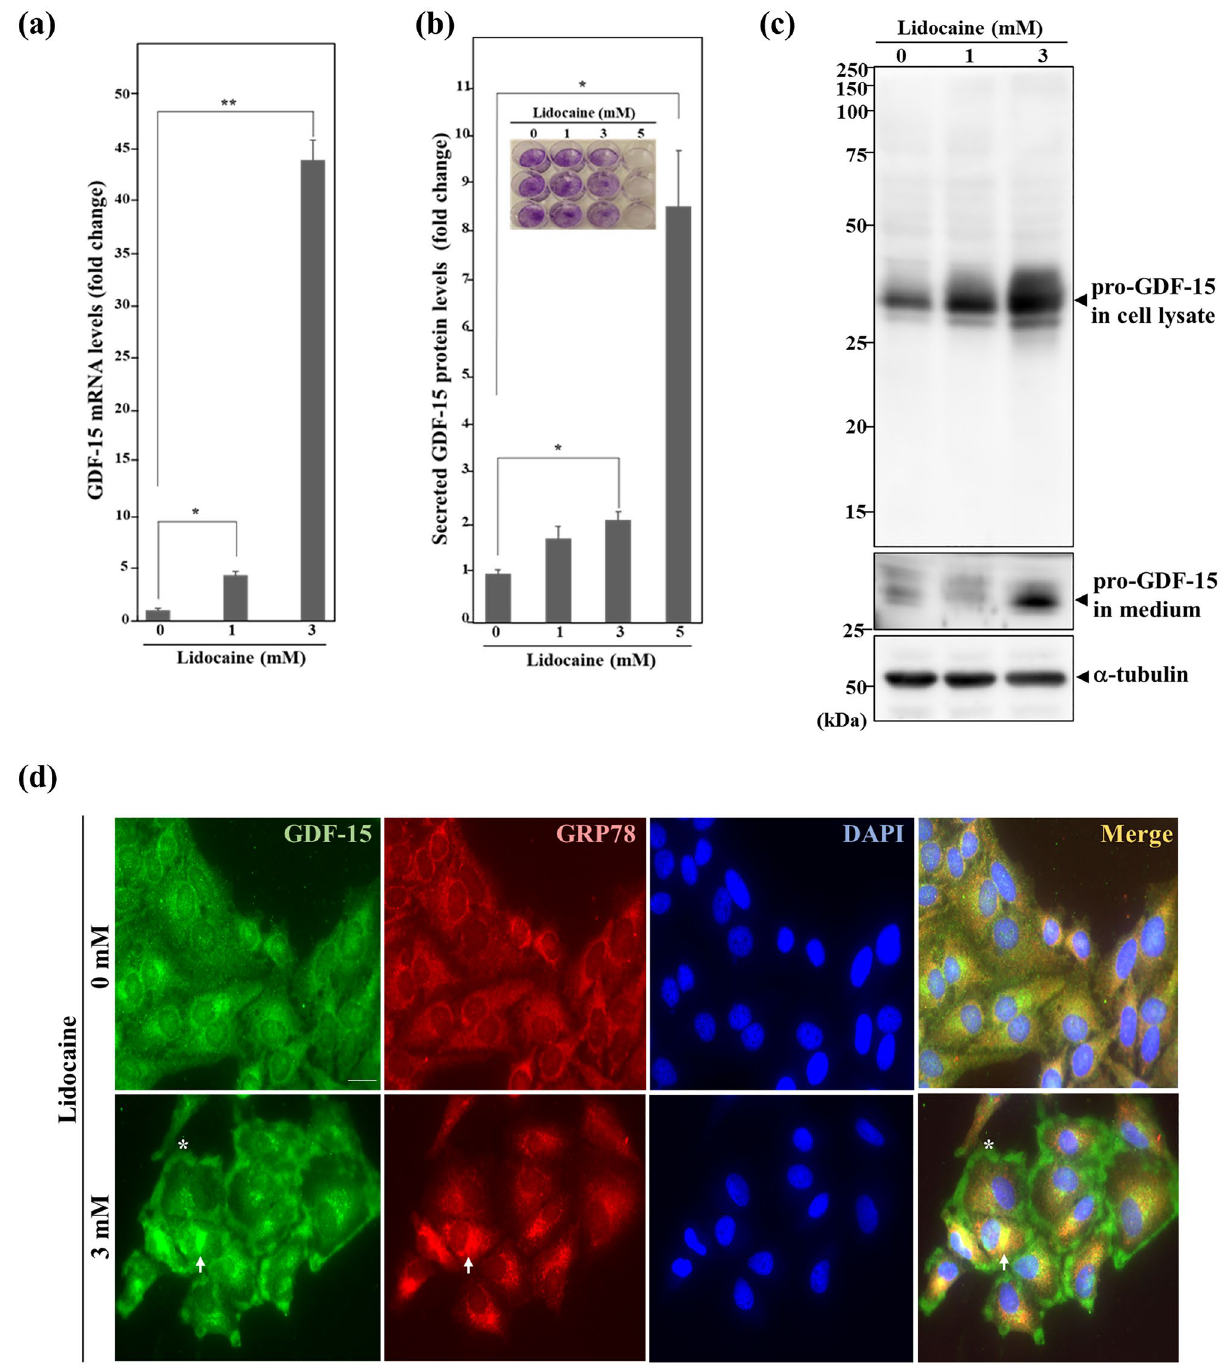
Figure 3. Increased expression and secretion of pro-protein GDF-15 with lidocaine treatment. ( a ) Level of GDF-15 mRNA after lidocaine treatment by qPCR. Total RNA purified from lidocaine-treated HeLa cells for 24 h were used for reverse transcription and qPCR analysis using GDF-15 and GAPDH primers. The results were normalized by the expression levels of GAPDH at the indicated lidocaine concentration. The level of GDF-15 mRNA increased with lidocaine treatment. Each sample was assayed in triplicate and the results are presented as the mean ± SD. * p < 0.05, ** p < 0.001. ( b ) ELISA of GDF-15 using culture medium. HeLa cells were treated with the indicated concentration of lidocaine for 24 h. The results were normalized by the cell number, determined by staining the culture wells with 0.5% crystal violet. Secreted GDF-15 in the medium increased after lidocaine treatment. Each sample was assayed in triplicate. The results represent the mean ± SD. * p < 0.05. ( c ) Western blotting of GDF-15. Cell lysate and culture medium of HeLa cells treated with the indicated concentration of lidocaine for 24 h were subjected to blotting using GDF-15 and α-tubulin antibodies. Pro-protein form GDF-15 (pro-GDF-15, 34 kDa) in both cell lysate and medium increased after lidocaine treatment. ( d ) Immunofluorescence analysis using GDF-15 and GRP78 antibodies. GRP78 is an ER chaperon, serving as an ER marker. HeLa cells treated with 3 mM lidocaine for 24 h were used for assay. Nuclei were stained with DAPI. The arrow indicates increased GDF-15 in the ER, and the asterisk indicates GDF-15 accumulation in the pericellular region. The scale bar represents 10